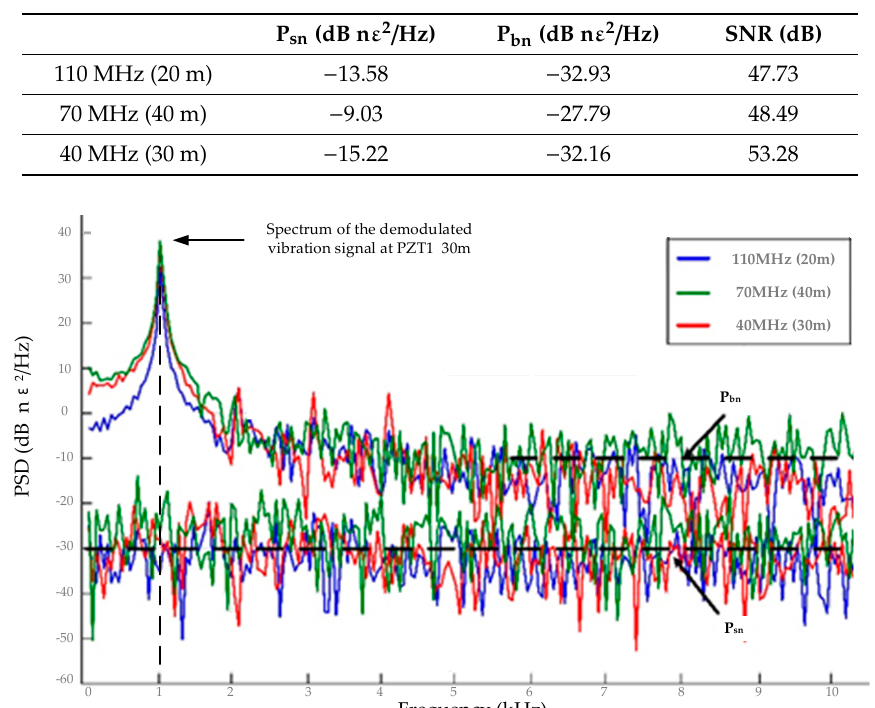
Figure 9. The power spectra of demodulated phase difference change signal and background noise at PZT1.